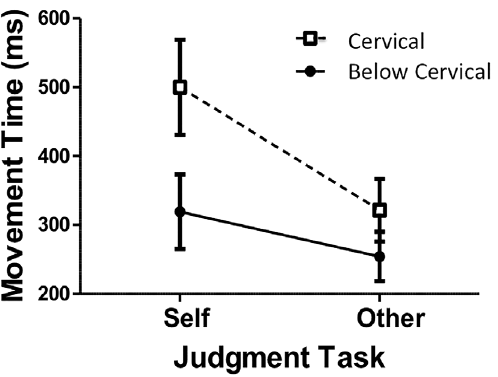
Figure 3. Mean movement times (ms) as a function of Group and Judgment Task. Open symbols with dashed connecting lines represent data from the group with cervical SCI. Closed symbols with solid connecting lines represent data from the group with below cervical SCI. SEM bars are